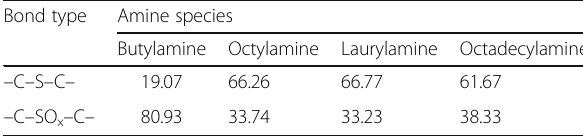
Table 2 The bonding configurations in the SA-GO (at%)